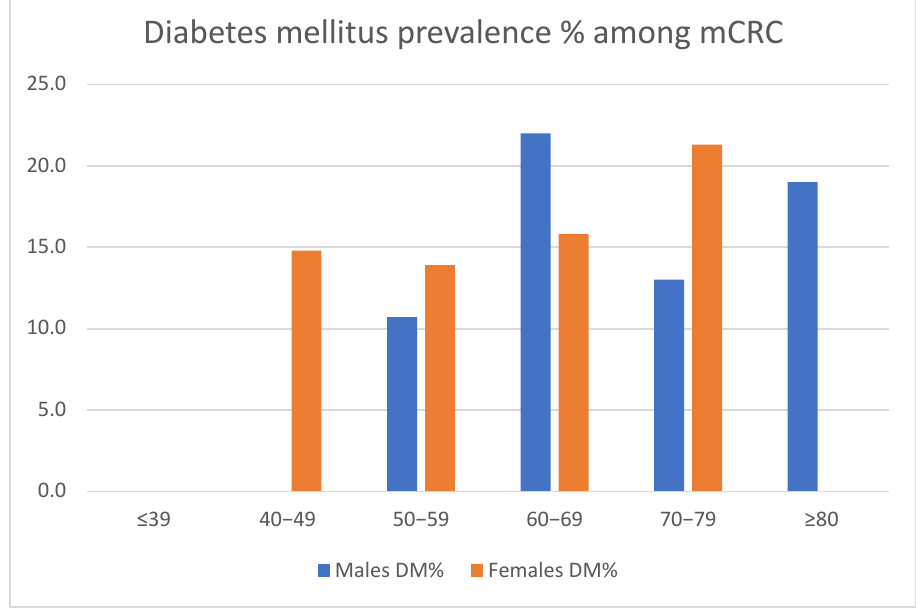
Figure 1. Diabetes mellitus prevalence among metastatic colorectal cancer study group (mCRC) according to age groups.